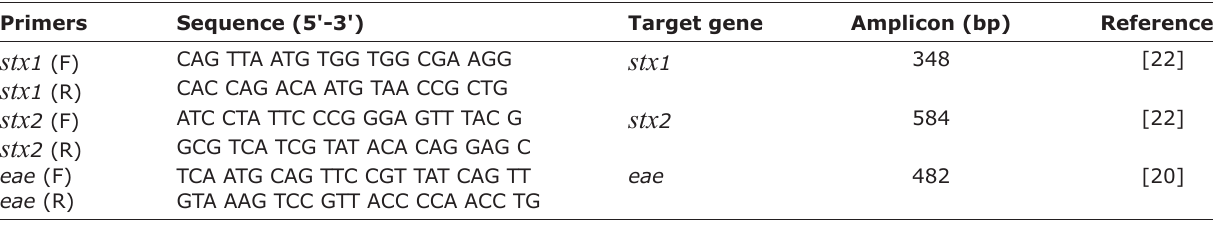
Table-1: Details of primers used for PCR reaction.